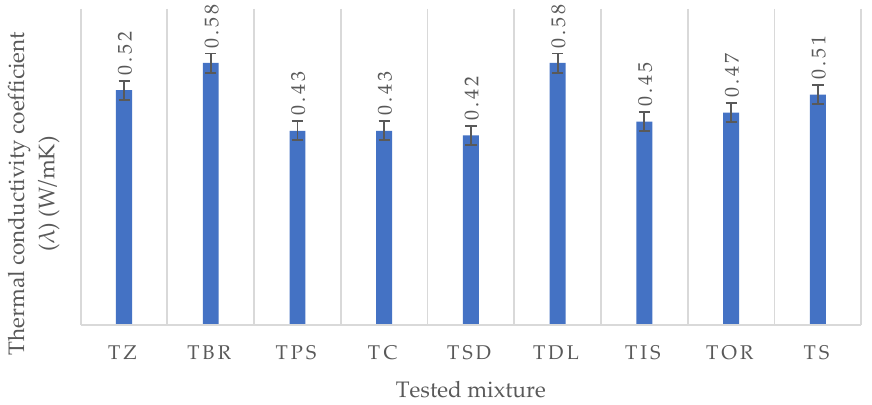
Figure 11. Thermal conductivity values for every tested addition including 100% clay.